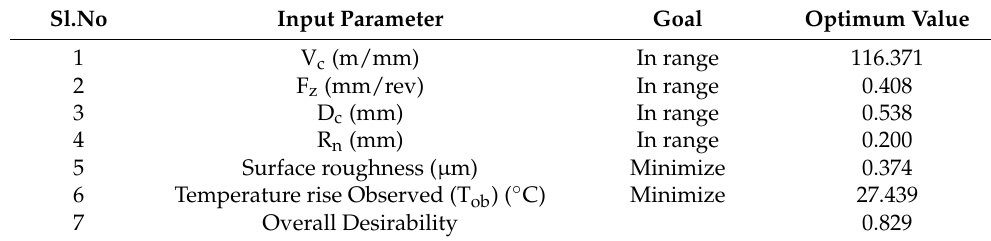
Table 8. Optimum values during turning of aluminum.